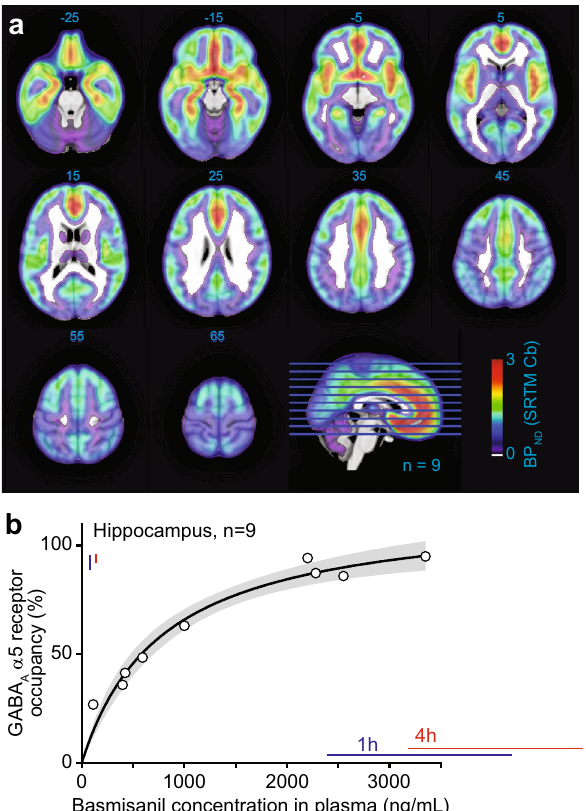
Figure 5. Dose-dependent GABA A -α5 receptor occupancy by basmisanil in human brain. ( a ) Representative [ 11 C]-Ro 15-4513 PET images in healthy human subjects showing the GABA A -α5 receptor distribution. BP ND binding potential, SRTM simplified reference tissue model, Cb cerebellum. Numbers for each slice indicate the axial slice location in MNI coordinates. Blue and red bars indicate plasma exposure and receptor occupancy ranges (mean ± standard deviation) at time-points where EEG was recorded (1 h and 4 h post morning dose after 14 days of 240 mg basmisanil dosing twice daily). ( b ) Relation between basmisanil concentration in plasma and receptor occupancy derived from nine subjects. Emax model fit (E = Emax × C/(EC 50 + C)), gray band indicates 95% confidence interval determined by the profile likelihood method. Blue and red bars indicate mean ± SD of blood plasma concentrations in the EEG experiment at 1 h and 4 h post morning dose at day 14,